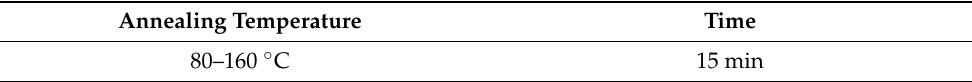
Table 2. Parameter of annealing